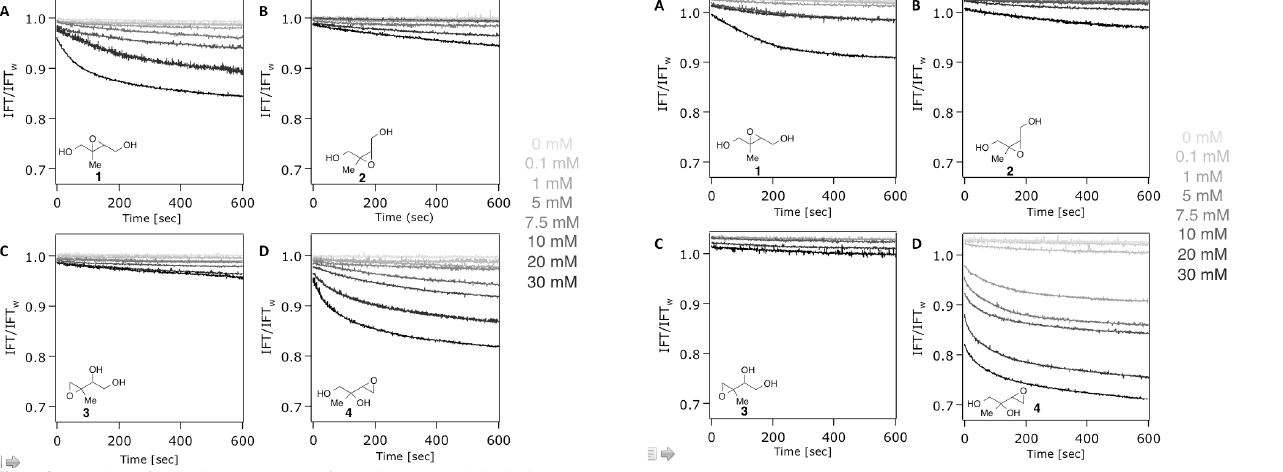
Figure 2. Dynamic surface tension measurements for IEPOX com- 352 pounds in d H 2 O. (a) trans- β -IEPOX (1) (b) cis- β -IEPOX (2) (c) δ -IEPOX (3) and (d) α -IEPOX (4).